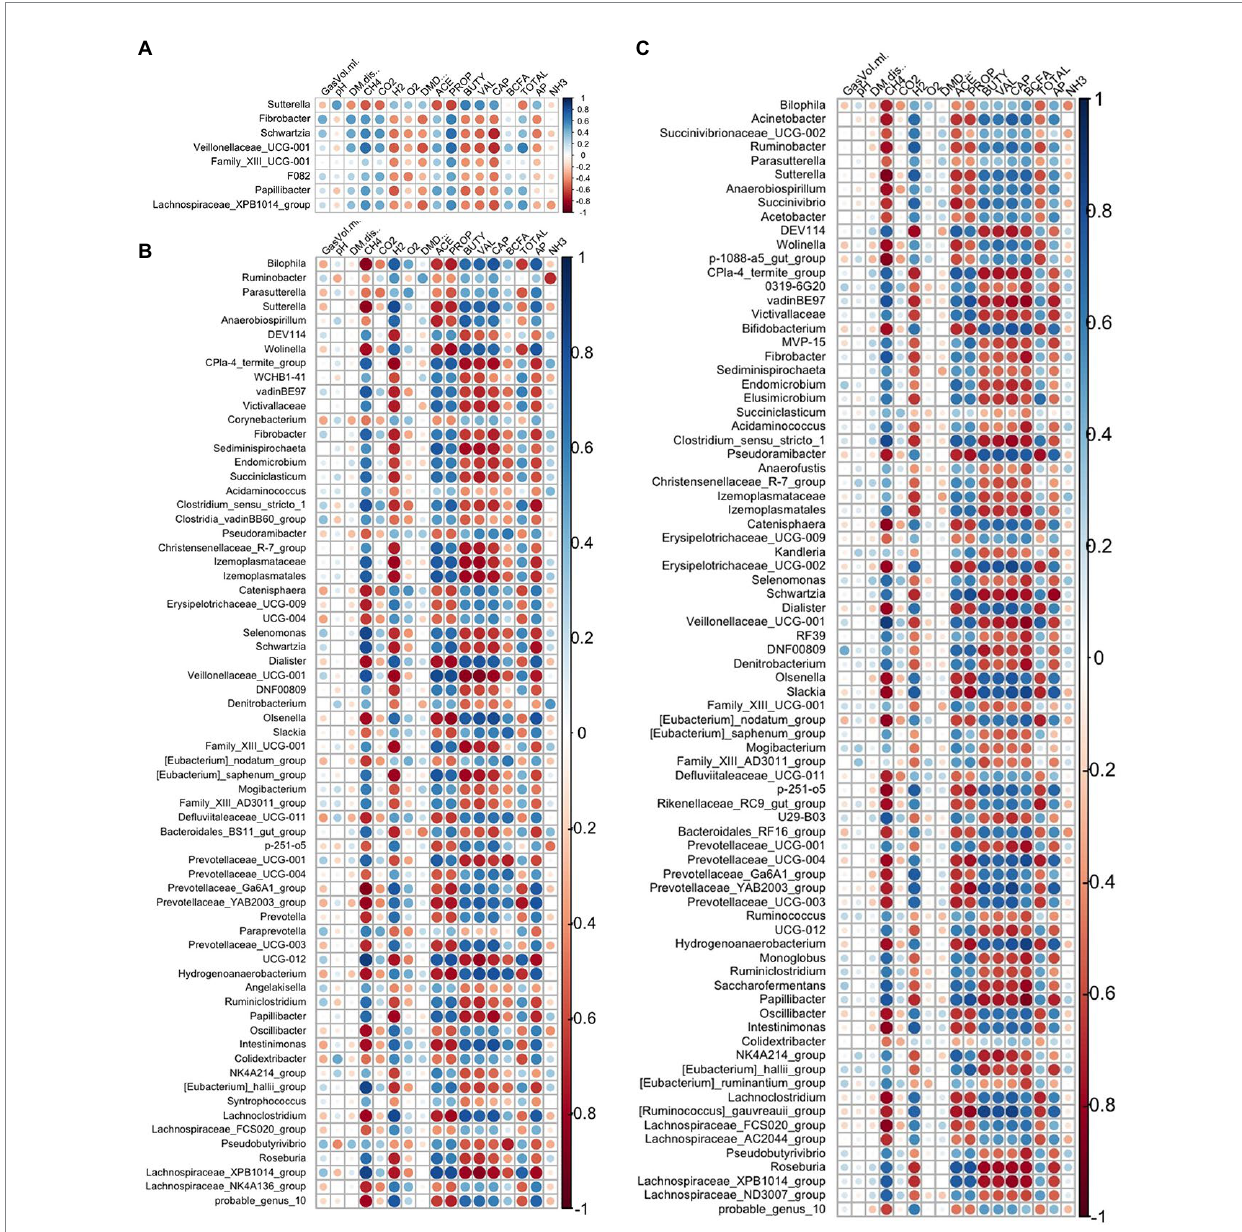
FIGURE 10 Spearman correlation analysis plots between the differentially abundant genera and fermentation variables during the (A) adaptation, (B) intermediate, and (C) stabilized phases. Raw bacterial abundances were log-transformed prior to correlation. GasVol.ml, total gas volume in mL; DM.dis., dry matter disappearance; CH4, methane; CO2, carbon dioxide; H2, hydrogen; O2, oxygen; DMD, dry matter digestibility; ACE, acetate; PROP, propionate; BUTY, butyrate; VAL, valerate; CAP, caproate; BCFA, branched-chain fatty acids; TOTAL, total VFA; AP, acetate: propionate ratio; NH3, ammonia. Individual sample values for all measurements are provided in the Supplementary